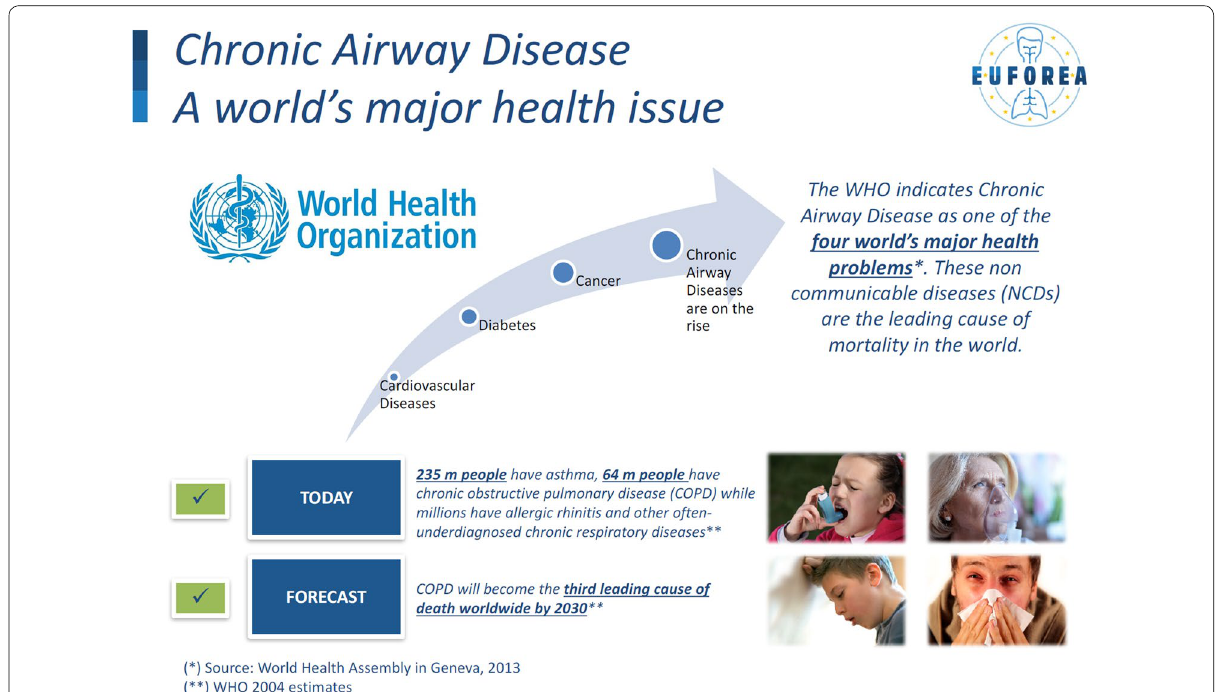
Fig. 1 Chronic airway